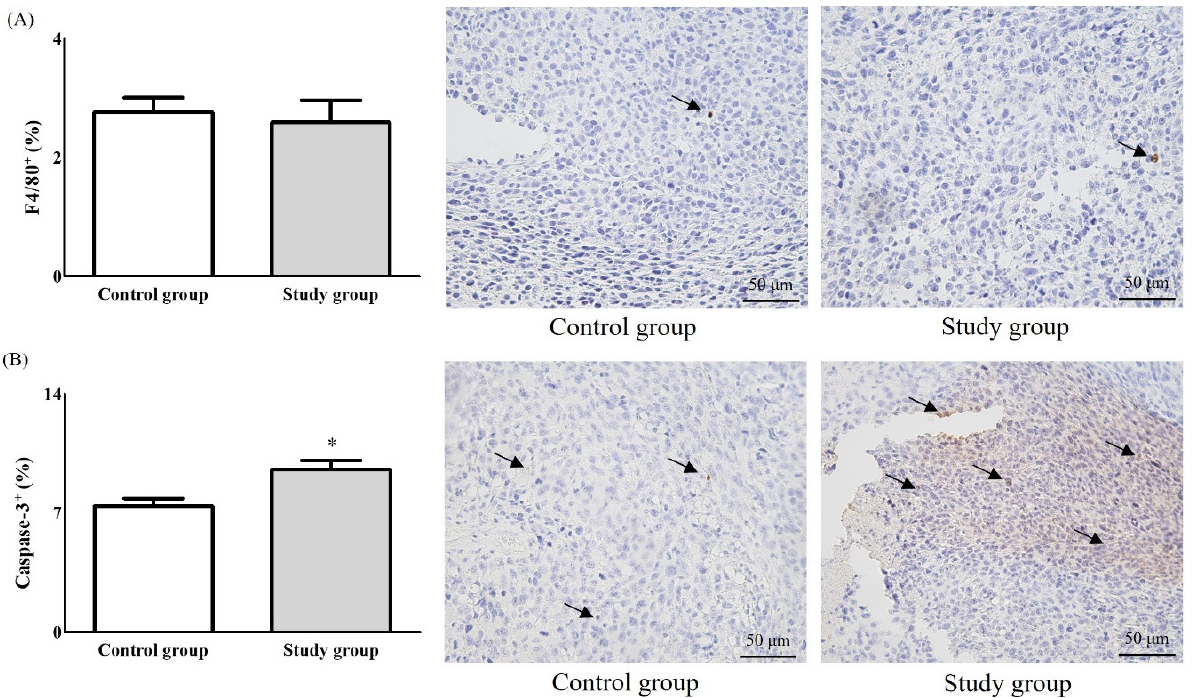
Figure 5. Immunohistochemistric analysis with the expressions of F4/80 + ( A ) for macrophages and caspase-3 ( B ) for cancer cells. *: p < 0.05. The arrows means “F4/80+” in Figure 5A and “Caspase-3” in Figure 5B,